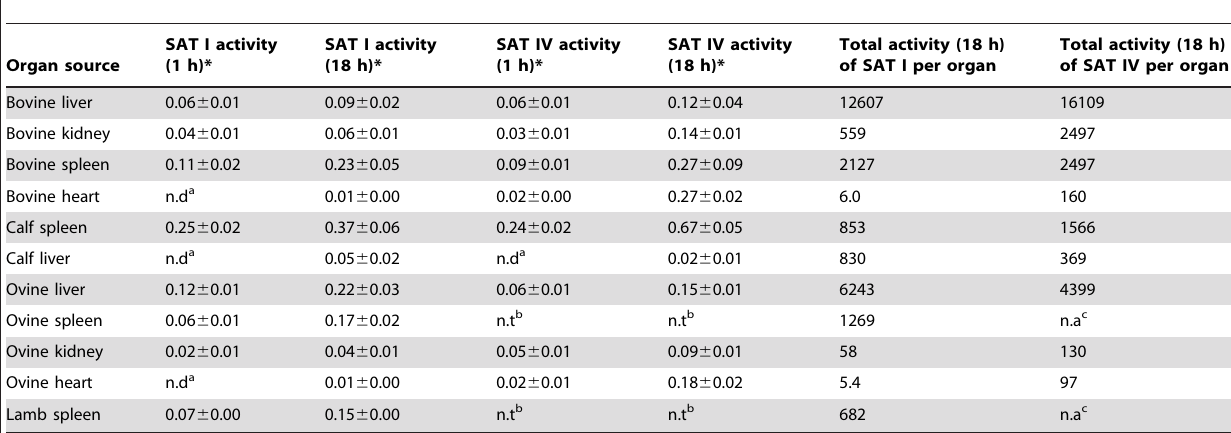
Activity is defined as 1 nmol of product formed per mg of protein in the defined period of time. *The data were an average from two measurements. The error represents the differences between the high and low values of the duplicate samples. a not detected; b not tested; c data not available.